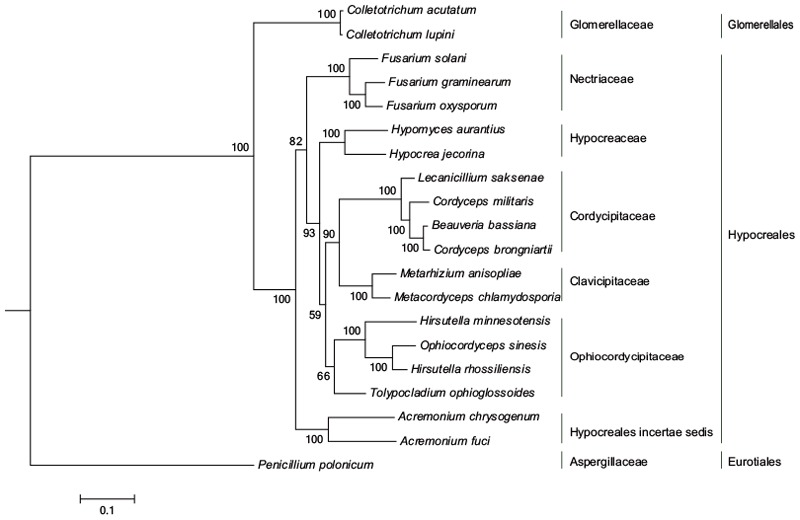
ML phylogeny of O. sinensis based on 14 PCGs in mt genome. The phylogenetic tree was inferred from a concatenated alignment of 14 PCGs (atp6, atp8, atp9, nad1-nad6, nad4L, cob, and cox1-cox3) using ML analysis. Numbers above branches specify bootstrap percentages (500 bootstrap replicates). MEGA 7.0 was used to determine the best evolutionary model (GTR+R) and RAxML 8.0 was used to infer the phylogenetic tree.